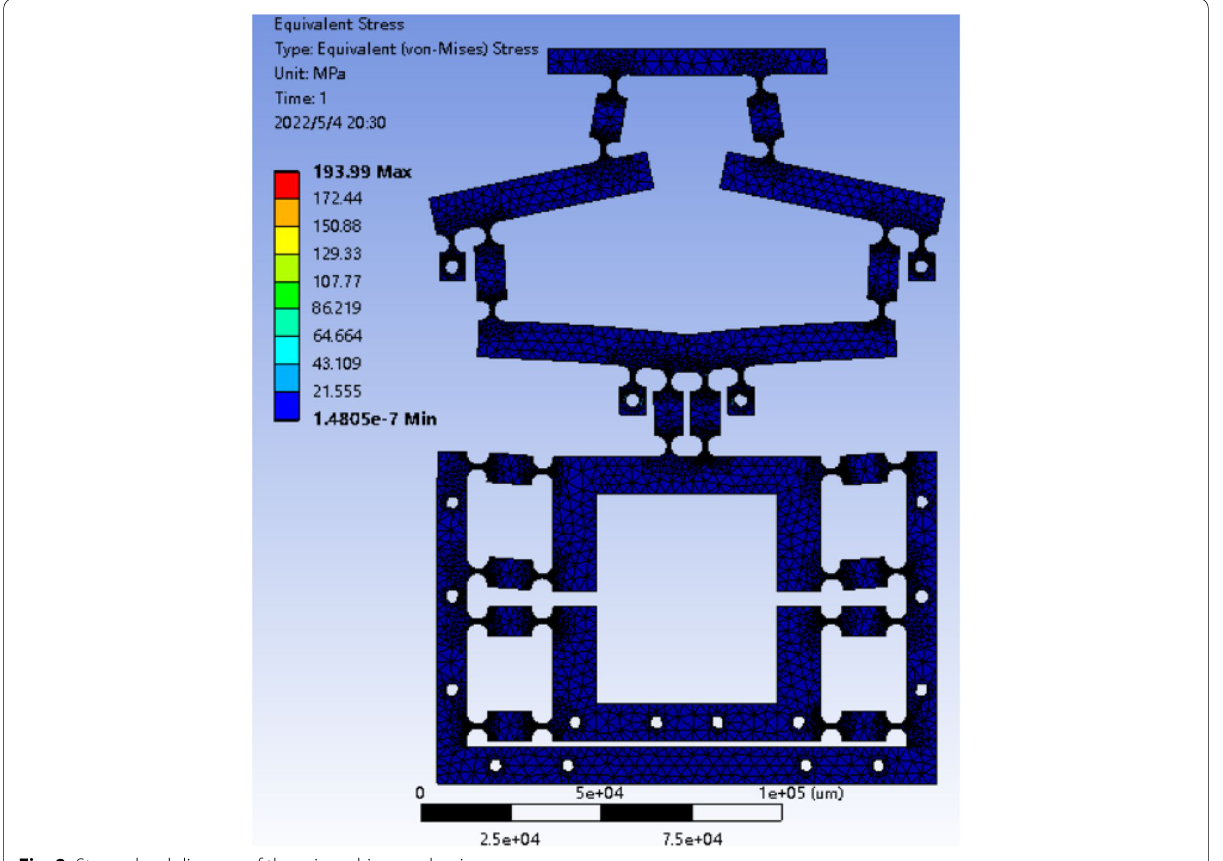
Fig. 8 Stress cloud diagram of the micro-drive mechanism